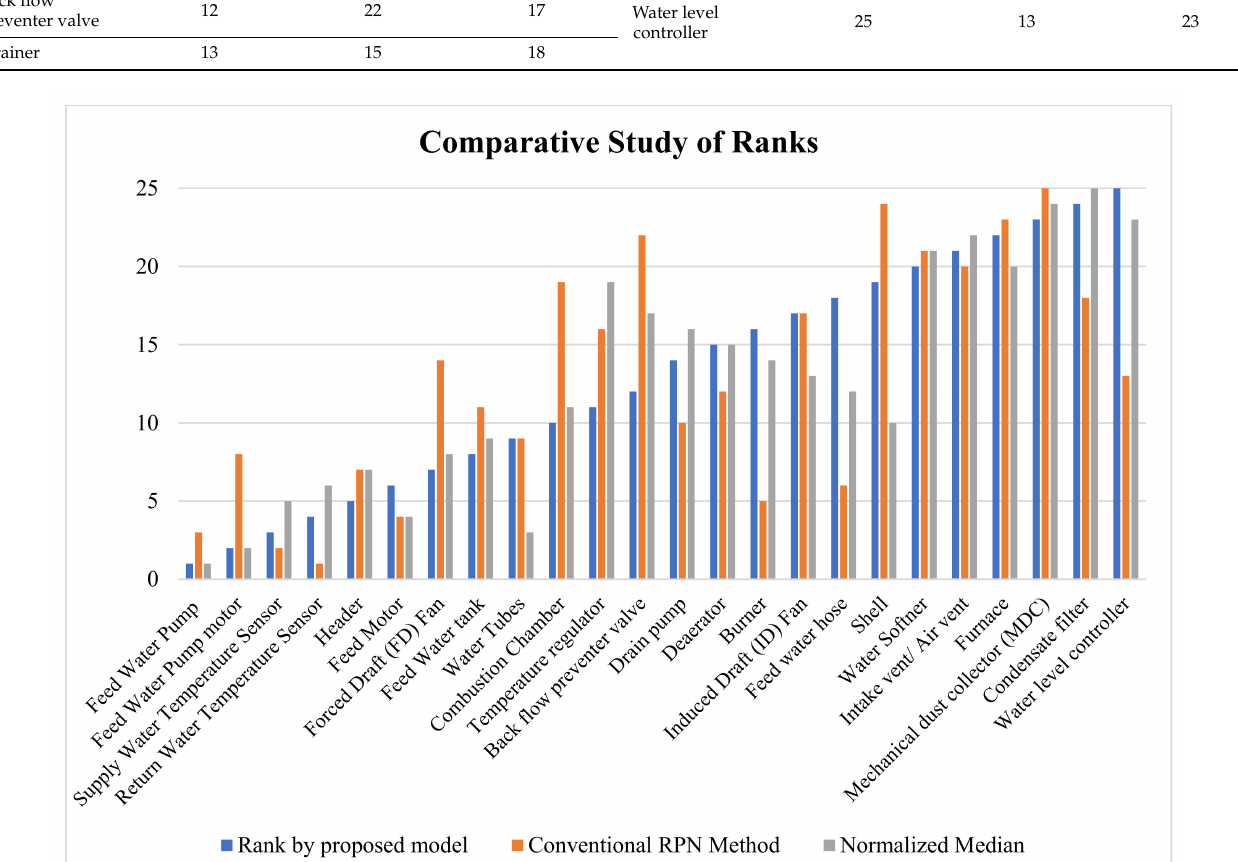
Figure 2. The histogram of the component rankings of the boiler system by conventional method and proposed